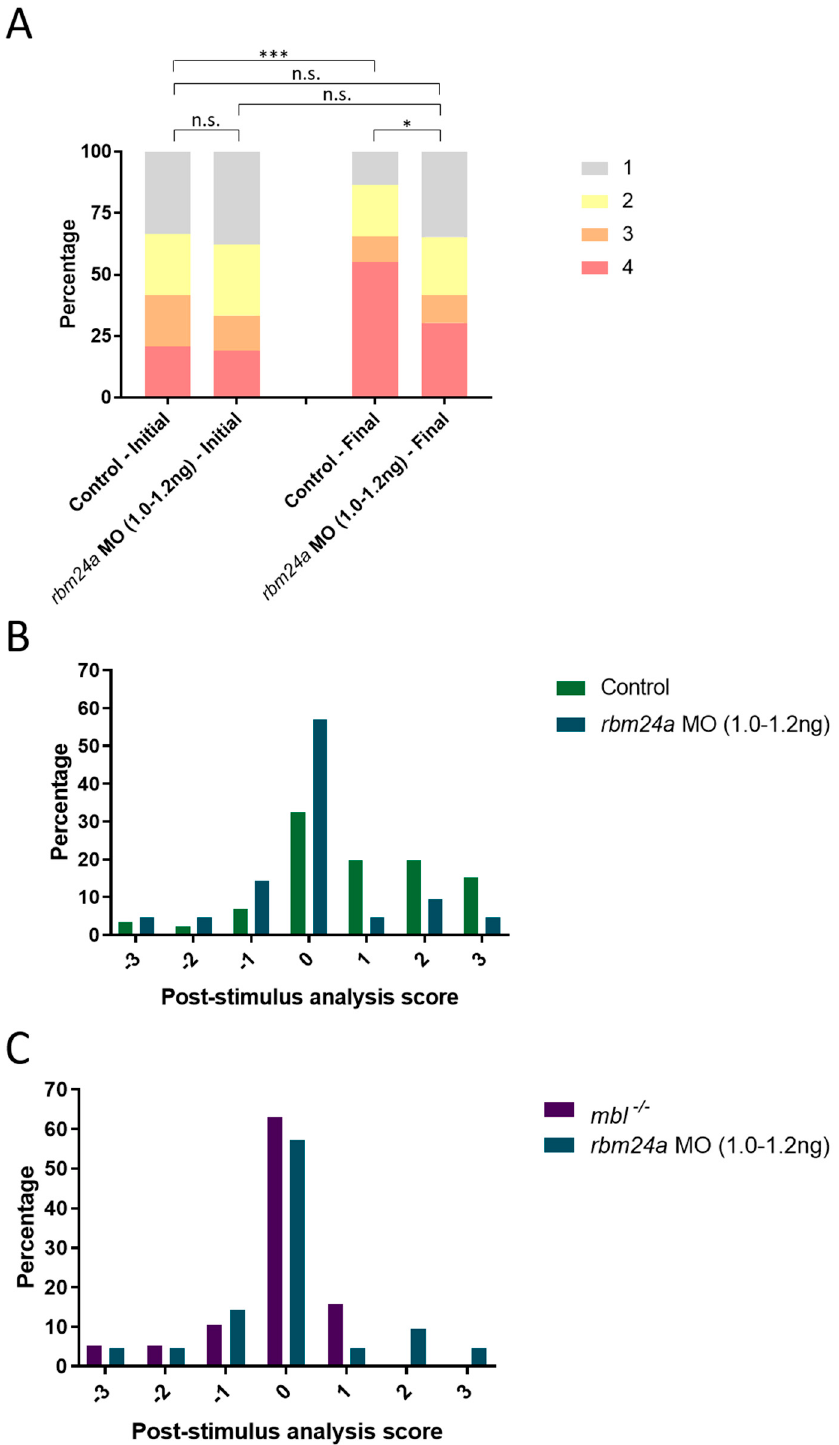
Figure 5. rbm24a morphants are visually impaired and unable to respond to OMR. ( A ) OMR analysis of control ( n = 19), rbm24a AUG MO at 1.0–1.2 ng ( n = 18), and rbm24a AUG MO at 2.0–2.5 ng ( n = 10) larvae plotted as a bar graph which shows the shifts in the population between the initial and final positions (Bowker’s test of symmetry p -value *** = 0.0004; Wilcoxon–Mann–Whitney p -value * = 0.0094); ( B ) Individual analysis of rbm24a morphant compared to wild type; ( C ) individual analysis of rbm24a morphant compared to mbl − / − . In contrast to wild type fish, rbm24a morphant fish do not align with the OMR, indicating a visual defect. n.s., not significant.